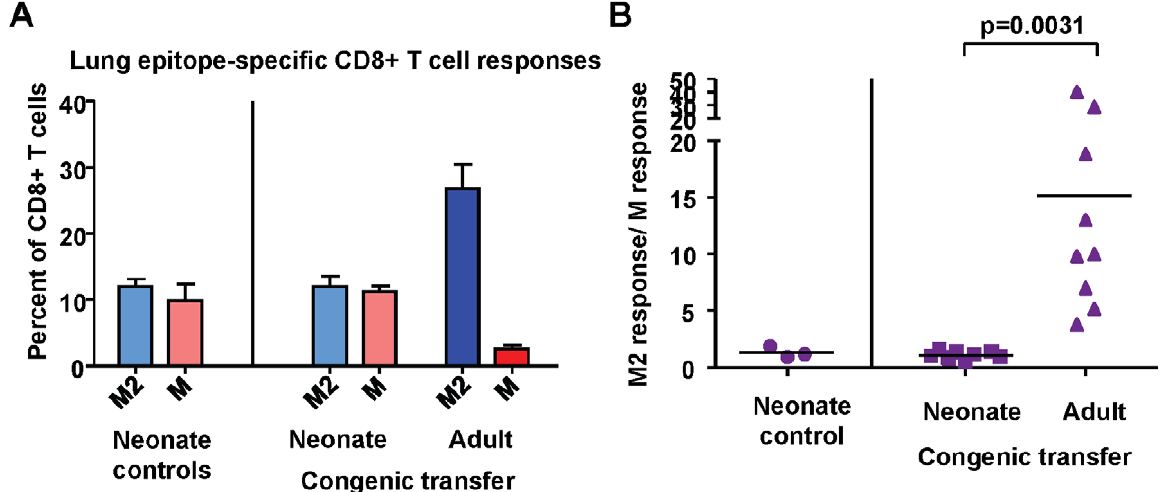
Figure 10. Intrinsic CD8 + T cell factors contribute to epitope hierarchy post-infection. (A) K d M2 82-90 and D b M 187-195 -specific CD8 + T cells in the lungs of control neonatal mice, and neonatal mice that received congenic transfer of naı¨ve adult CD8 + T cells. (B) Epitope-specific CD8 + T cell response ratios in control neonatal mice and neonatal mice that received congenic transfer of naı¨ve adult CD8 + T cells. Data are representative of several independent experiments with 3-10 mice/group. Error bars represent the SEM.